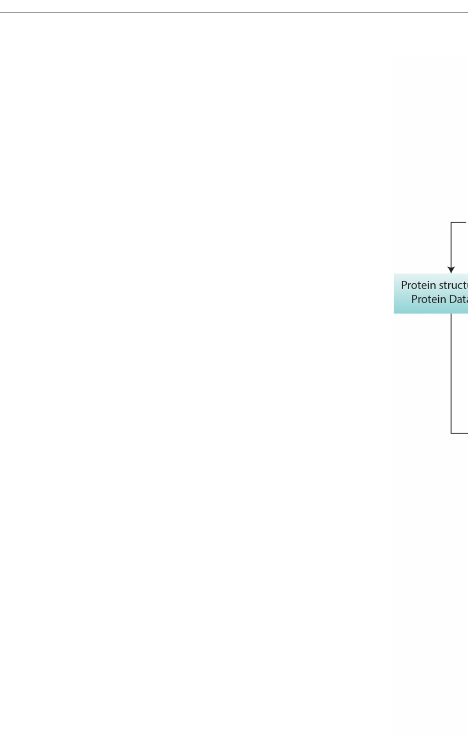
FIGURE 1 | Methodology work fl ow: the sequence and structure information of 7 pancreatic cancer receptors ( Table 1 ) and L5 proteins of HAdV2, HAdV3, and HAdV5 ( Table 2 ) were retrieved from UniProt. Then PSI-Blast was performed. Protein Data Bank (PDB) structures of proteins with available structures were downloaded from the PDB database. Machine learning-based structure prediction was performed for proteins with a sequence identity of less than 60%. The 50-ns molecular dynamic (MD) simulation was performed to re fi ne the predicted models. Then pancreatic cancer receptors and HAdV L5 proteins were docked and re fi ned. Then interaction analysis of both interacting molecules was